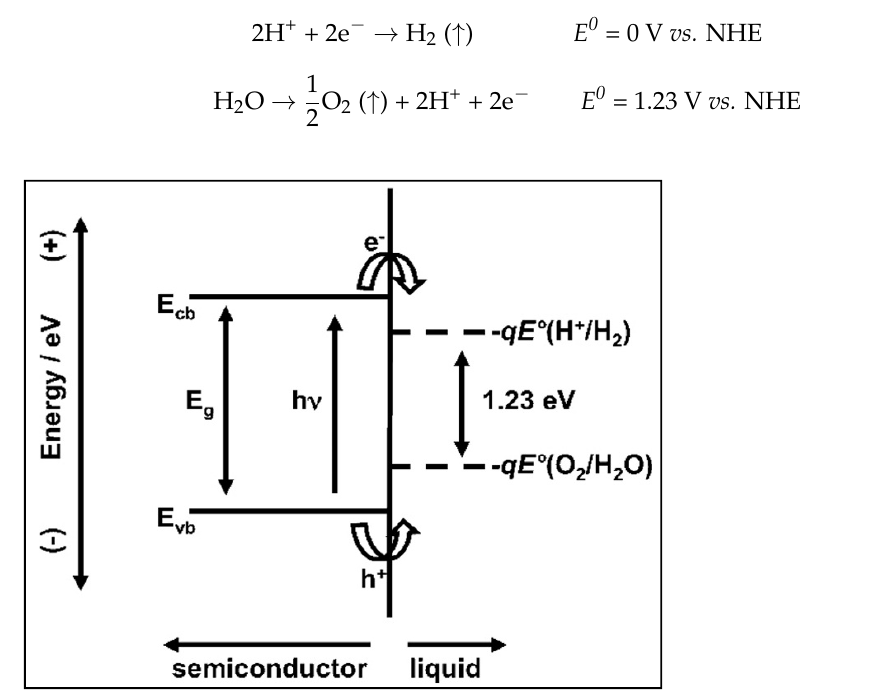
Figure 4. Photocatalytic water splitting at the surface of an irradiated semiconductor, reprinted from reference [152]. Copyright 2010 American Chemical Society. reference [152]. Copyright 2010 American Chemical